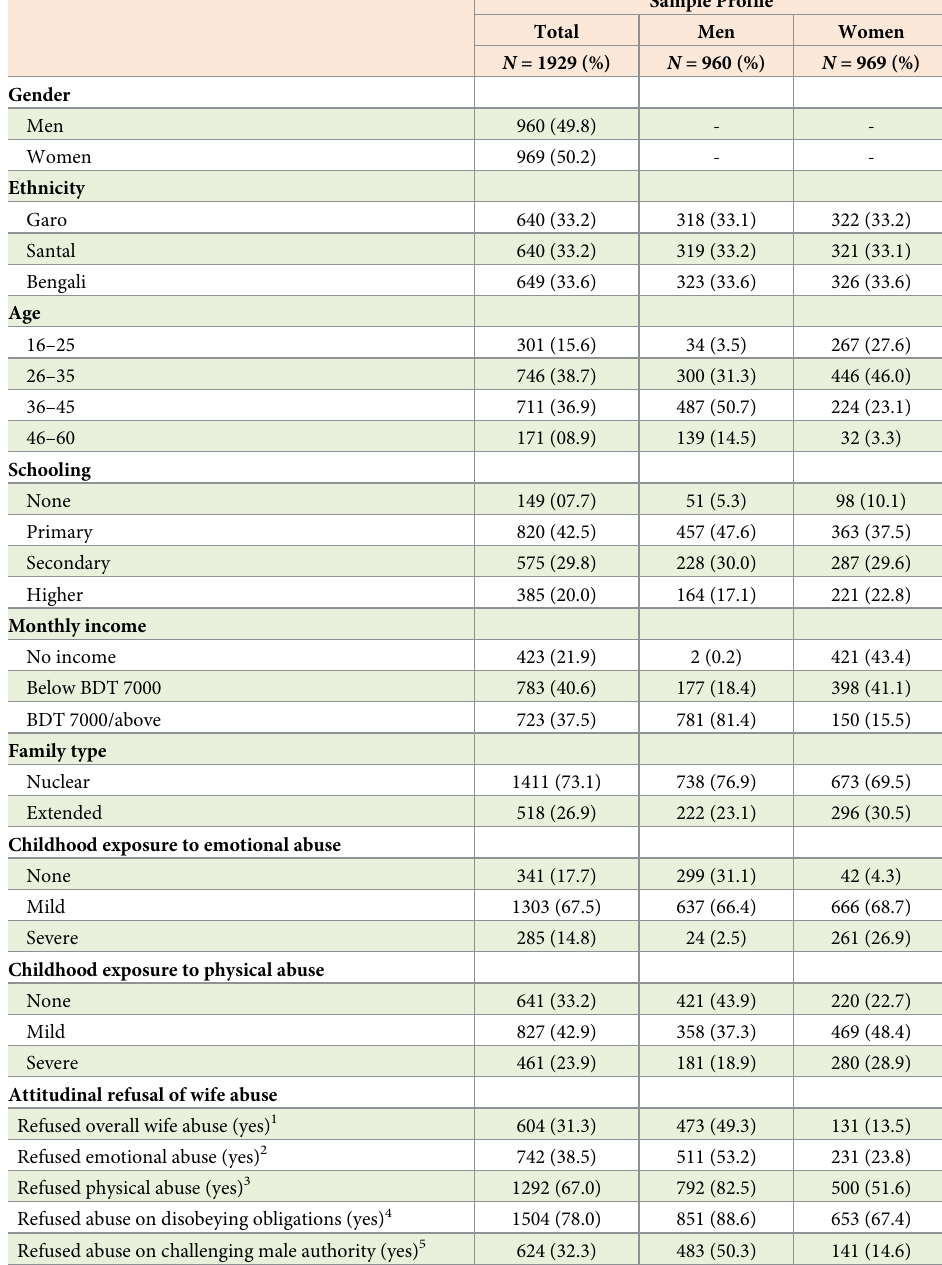
Table 1. Prevalence of the different types of attitudinal refusal of wife abuse by